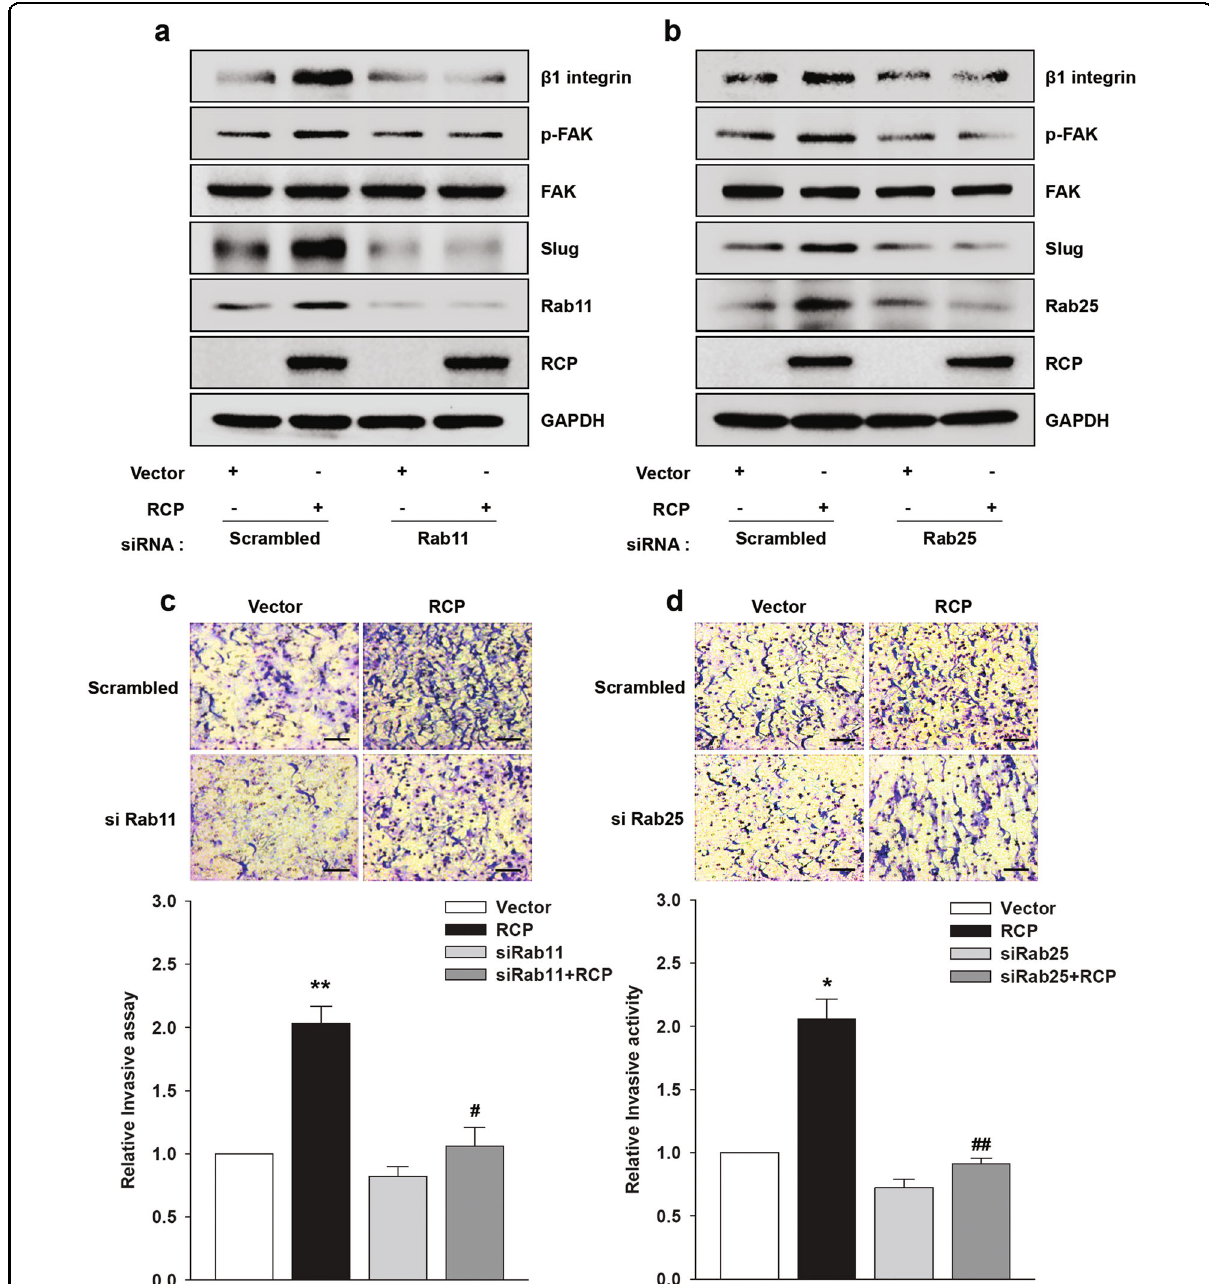
Fig. 4 Rab11 and Rab25 are required for RCP-induced FAK phosphorylation. a , b SKOV-3 cells were co-transfected with the indicated vectors and siRNAs for 48 h. Immunoblotting and c , d invasion assays (mean± s.d. * P < 0.05, ** P < 0.01 vs. the control vector, # P < 0.05, ## P < 0.01 vs. RCP overexpression with scrambled siRNA). Original magni fi cation, ×200; scale bar, 200 μ m. All experiments were repeated three